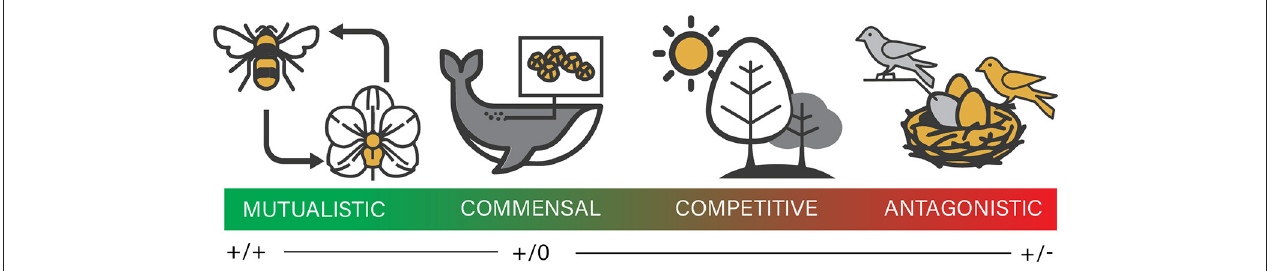
FIGURE 1 | Spectrum of species interactions range from mutualistic to antagonistic. Mutualistic: plants and their pollinators, such as orchids and orchid bees. Both members benefit from the interaction. Commensal: Barnacles benefit from settling on the whale’s skin surface, but do not impact the whale. Competitive: plants competing for access to canopy light in a forest. Antagonistic: The cuckoo lays its egg in the nest of another species of (host) bird. The host bird incurs the cost of raising the cuckoo’s young instead of its own (which the cuckoo hatchling